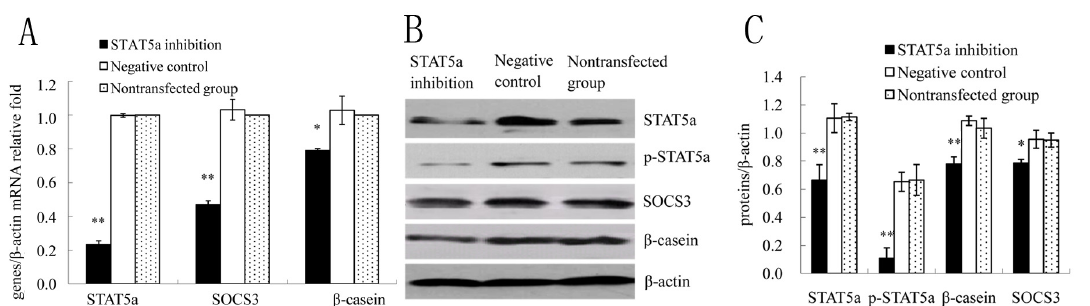
Figure 3. STAT5a was necessary for SOCS3 expression in DCMECs. DCMECs were divided into three groups: transfected with a STAT5a siRNA or negative control (control group), nontransfected, grew for 48 h. ( A ) Relative mRNA levels of STAT5a, SOCS3, β -casein genes in DCMECs growing for 24 h were measured by qRT-PCR after STAT5 inhibition. ( B ) Western blotting analysis of STAT5a, p-STAT5a, SOCS3, β -casein in DCMECs growing for 24 h subjected to STAT5a inhibition. β -actin served as loading control; ( C ) Results of gray scale scan of STAT5a, p-STAT5a, SOCS3 and β -casein/ β -actin relative fold by western blotting after STAT5a inhibition at 24 h. * or ** means significant difference compared with negative control ( p < 0.05 or p <